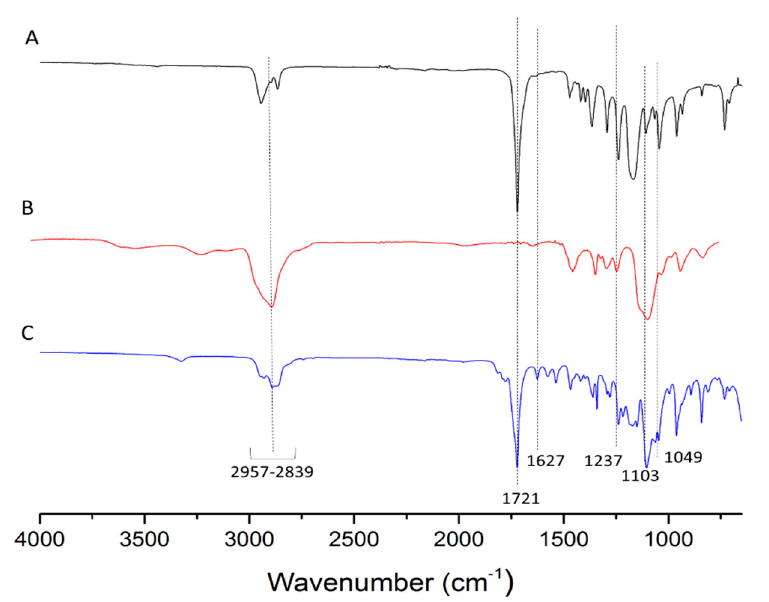
Figure 4. FT-IR spectra of ( A ) 5’-DFUR-PCL, ( B ) MPEG-NH 2 , and ( C ) 5’-DFUR-PCL-MPEG.